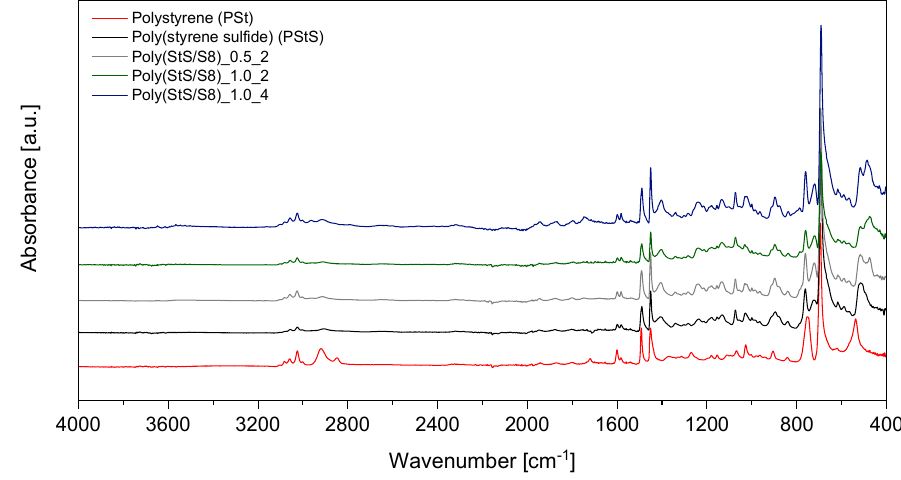
Figure 7. The FTIR spectra of the synthesized polysulfides and reference poly (styrene).